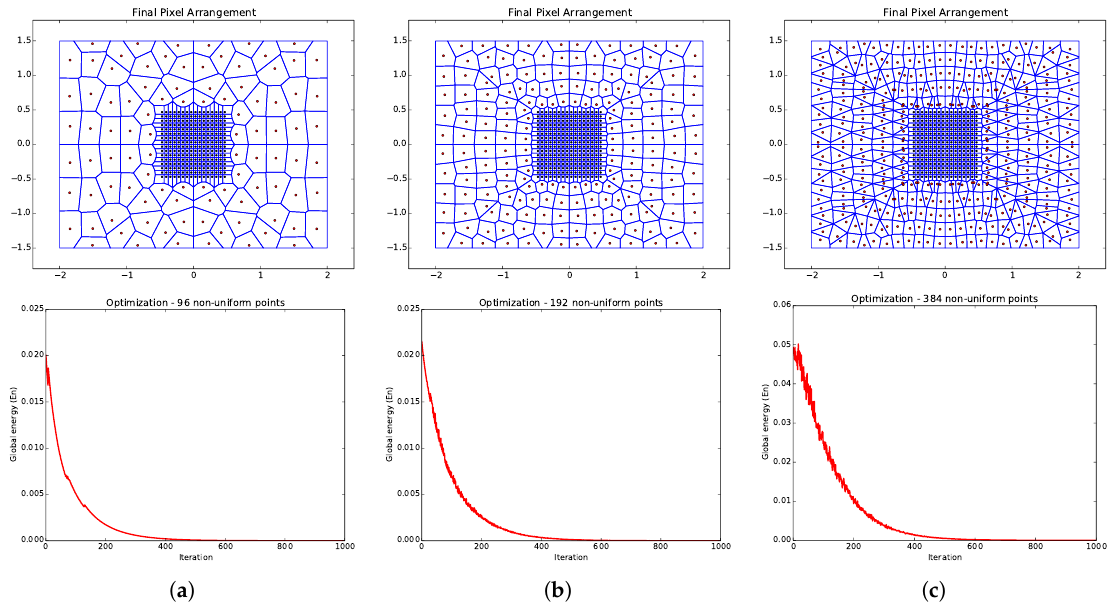
Figure 3. Convergence analysis for ARIMs with a single fovea and based on the l ∞ implicit function. Examples of ARIMs containing ( a ) 96, ( b ) 192, and ( c ) 384 non-uniform points in the periphery. For each ARIM, the resulting global energy curve over 1000 iterations of the generation process is shown in the model’s respective